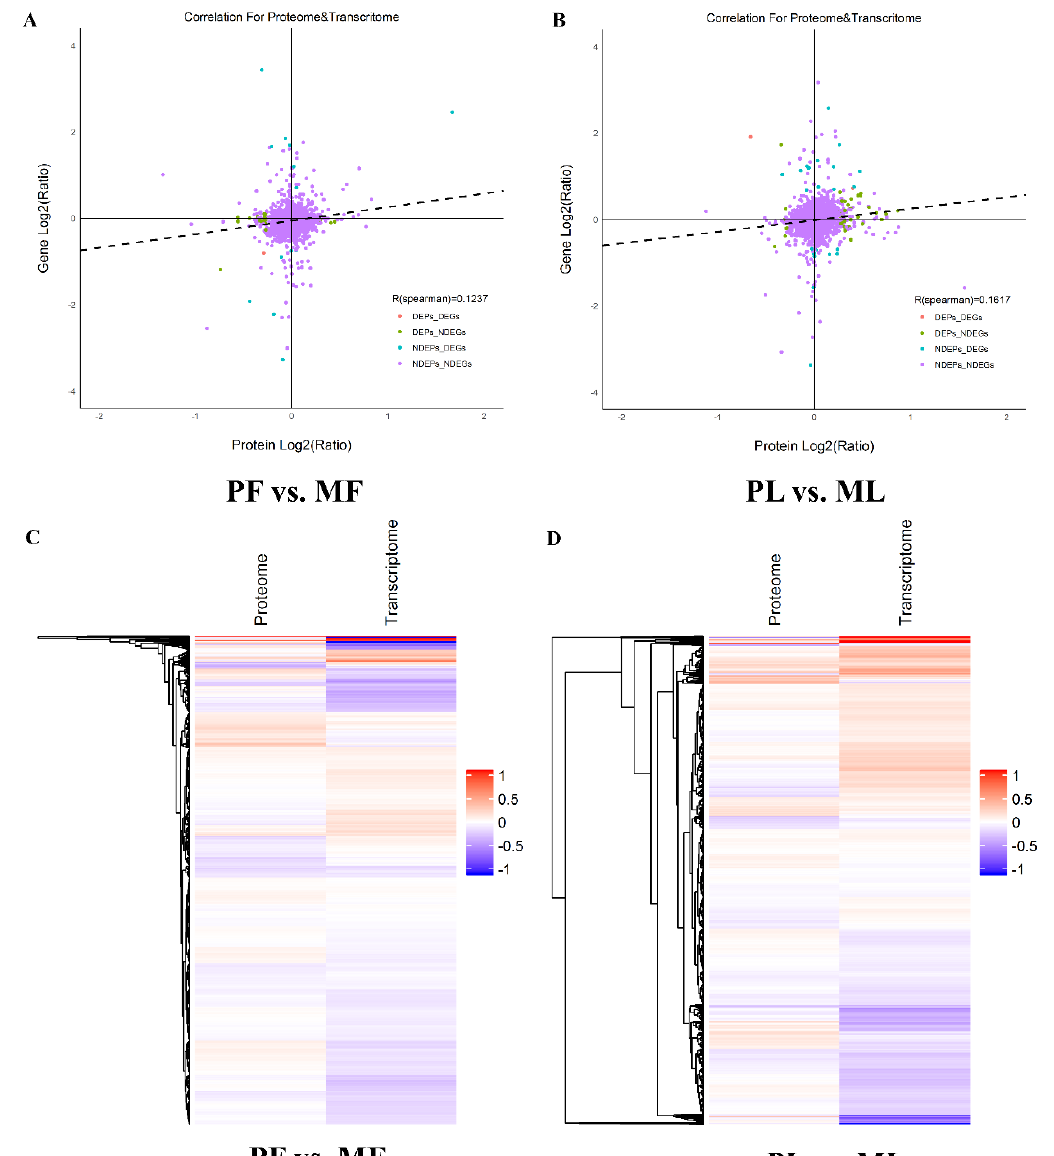
Figure 7. Correlative scatter plots of identified proteins and genes. ( A ) Correlative scatter plots of identified proteins and genes in PF vs. MF. ( B ) Correlative scatter plots of identified proteins and genes in PL vs. ML. ( C ) The heat map analysis of correlative proteins and genes in PF vs. MF. ( D ) The heat map analysis of correlative proteins and genes in PL vs. ML.